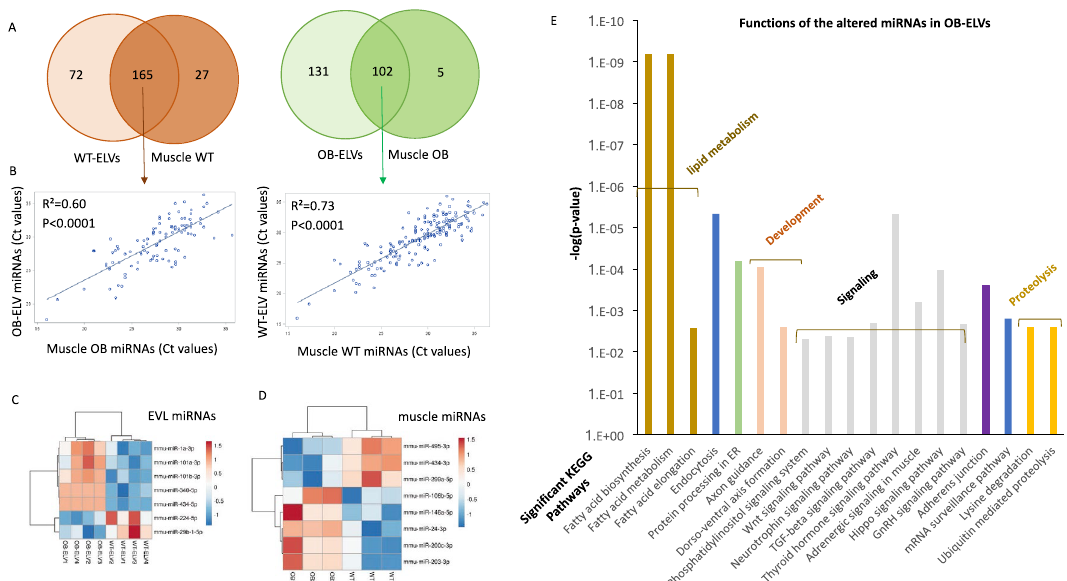
Figure 4. Altered miRNA content in OB-ELVs vs WT-ELV. ( A ) Venn Diagram showing the number of miRNAs commonly expressed between muscle and SkM-ELVs, or specific to each compartment. Given the low number of animals (n = 4) we have considered only the miRNAs expressed in all mice for each diagram. The mean Ct values of all miRNAs expressed in WT or OB muscle was not significantly different. ( B ) Correlations between the Ct values of miRNAs commonly identified between SkM-ELVs and Quad. ( C ) Heatmap showing the differentially concentrated miRNAs in SkM-ELVs or muscle ( D ), between OB and WT mice. ( E ) The significant KEGG pathways containing target genes from the 7 OB-ELV miRNAs (in C ) were determined by using DIANA miRPath. The 20 most significant KEGG pathways in terms of lowest p -values are shown.